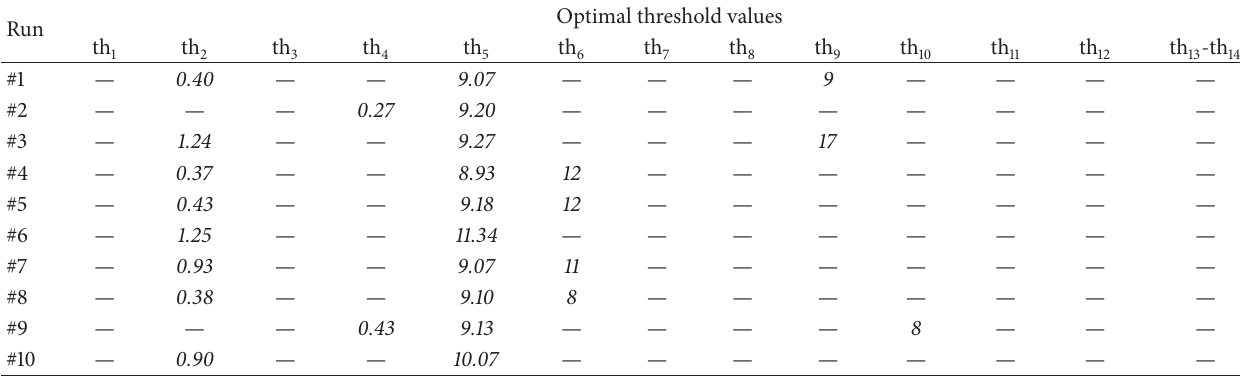
Table 10: Training results: the optimal decision threshold values of 10 runs using standard PSO.